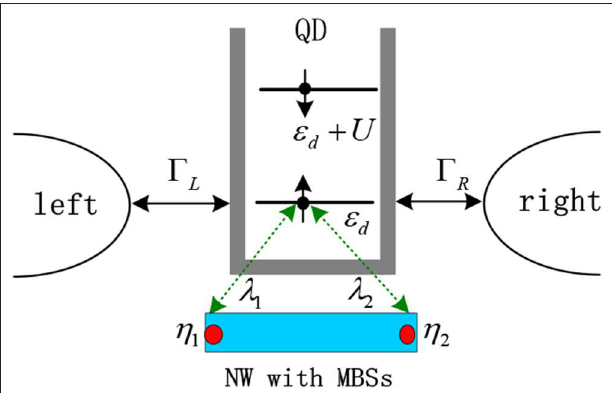
FIGURE 1 | Schematic diagram for a QD coupled to MBSs and the left and right ferromagnetic leads with coupling strength Ŵ L / R . Due to the chiral nature of the Majorana fermions, only spin-up is assumed to couple to the MBSs, formed at opposite ends of a nanowire. The two MBSs are denoted by η 1 and η 2 and coupled to the QD with strength of λ 1 and λ 2 , respectively. If the dot level ε d is occupied by an spin-up electron, then the spin-down electron will by U by the intradot Coulomb repulsion U pushed up to the level of ε d +